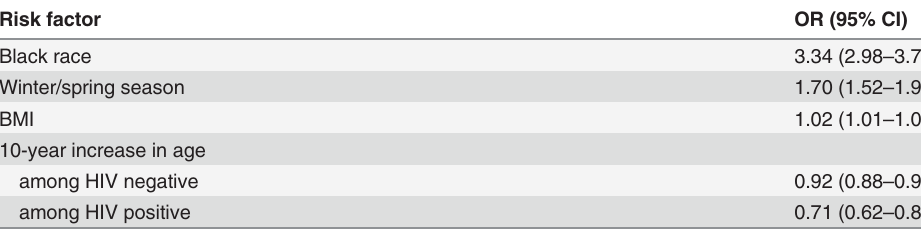
Table 3. Risk factors associated with Vitamin D deficiency, all patients; multivariate